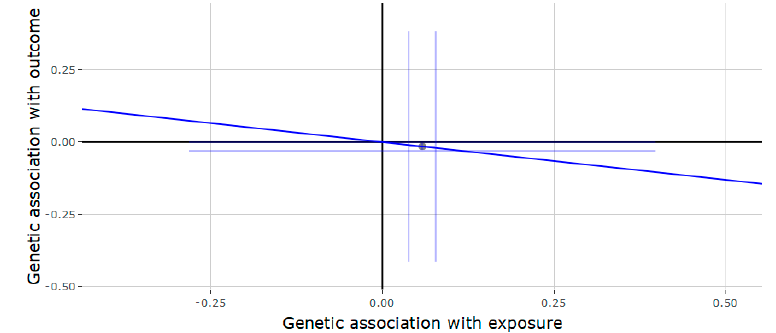
Figure 2. Genetic association of type II diabetes (T2D) against genetic association of testosterone ( JMJD1C locus). The slope (dark blue line) represents the causal association of testosterone with T2D (generated via inverse variance weighted Mendelian randomization), while the point on the plot and the lights around it (light blue lines) represent the SNP and its confidence intervals.